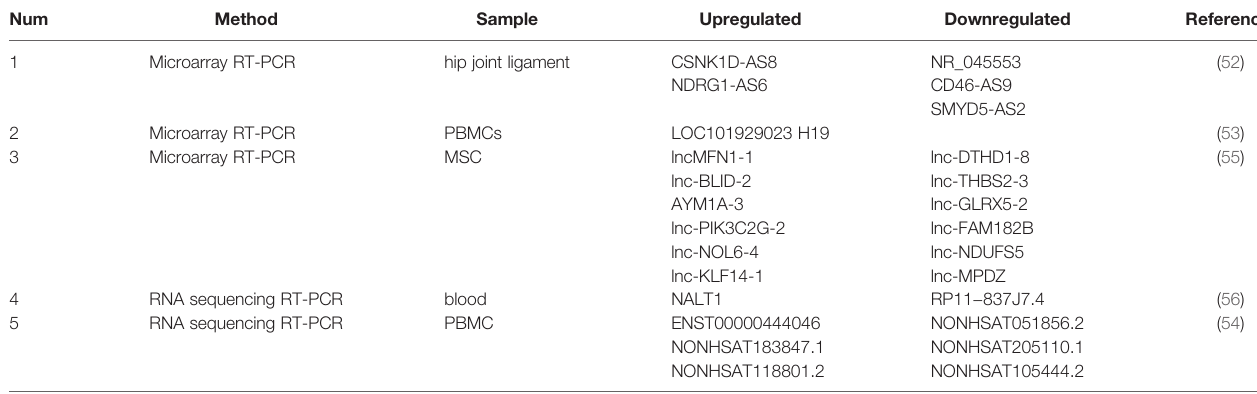
TABLE 2 | LncRNAs expression which was con fi rmed by qRT-PCR in ankylosing